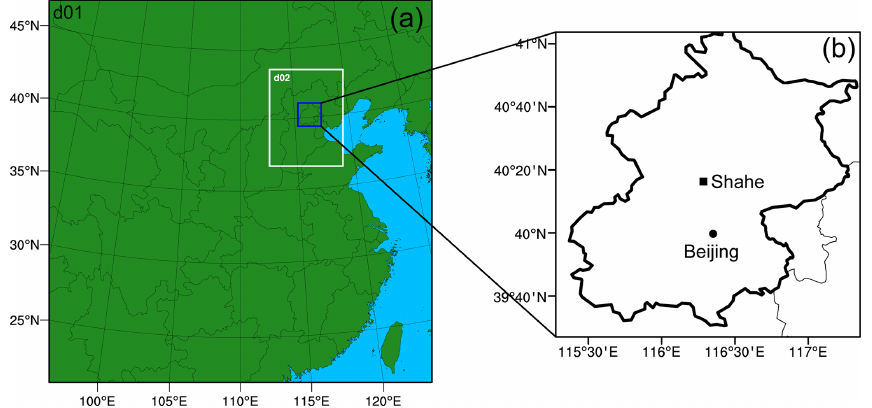
Figure 1. (a) Two nested domains with grid resolutions of 30km (d01) and 10km (d02). (b) The BC vertical profiles were modified for the blue box, which covers all of Beijing. Table 1. Physical and chemical options for